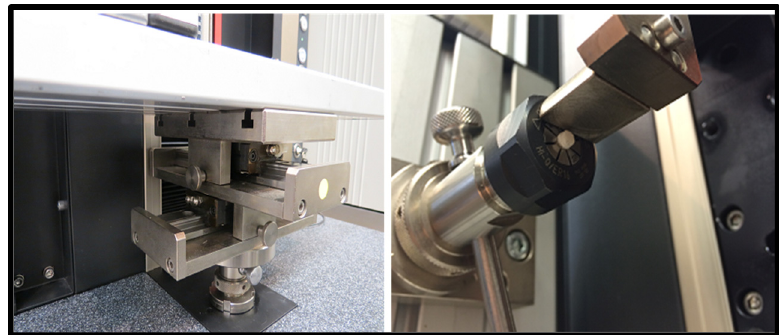
Figure 4. Sample fixed in the UTM before SBT; distant view ( left ), closer view ( right ).